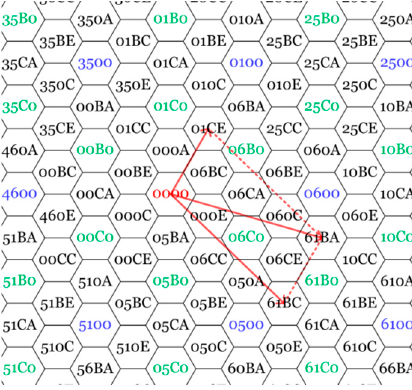
Figure A2. Illustration of part of the defined grid system.